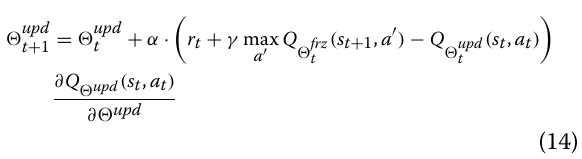
value of each action in each state. Therefore, by knowing 16 and 9 units. The first layer has Rectified Linear Unit the optimal Q-function, the policy can be derived as: (ReLU) activation while the second has a linear one. The reward function was formalized based on Section (cid:4) (cid:5) ∗ ( π ∗ ( s ) = arg max Q s , a ) | π a The representation of the Q-function tends to be chal- lenging when the number of possible state and action pairs are very high. This happens frequently and it is known as the curse of dimension. This can be tackled with applying neural networks to represent the Q-function. Our net- work architecture contains two fully connected layers with